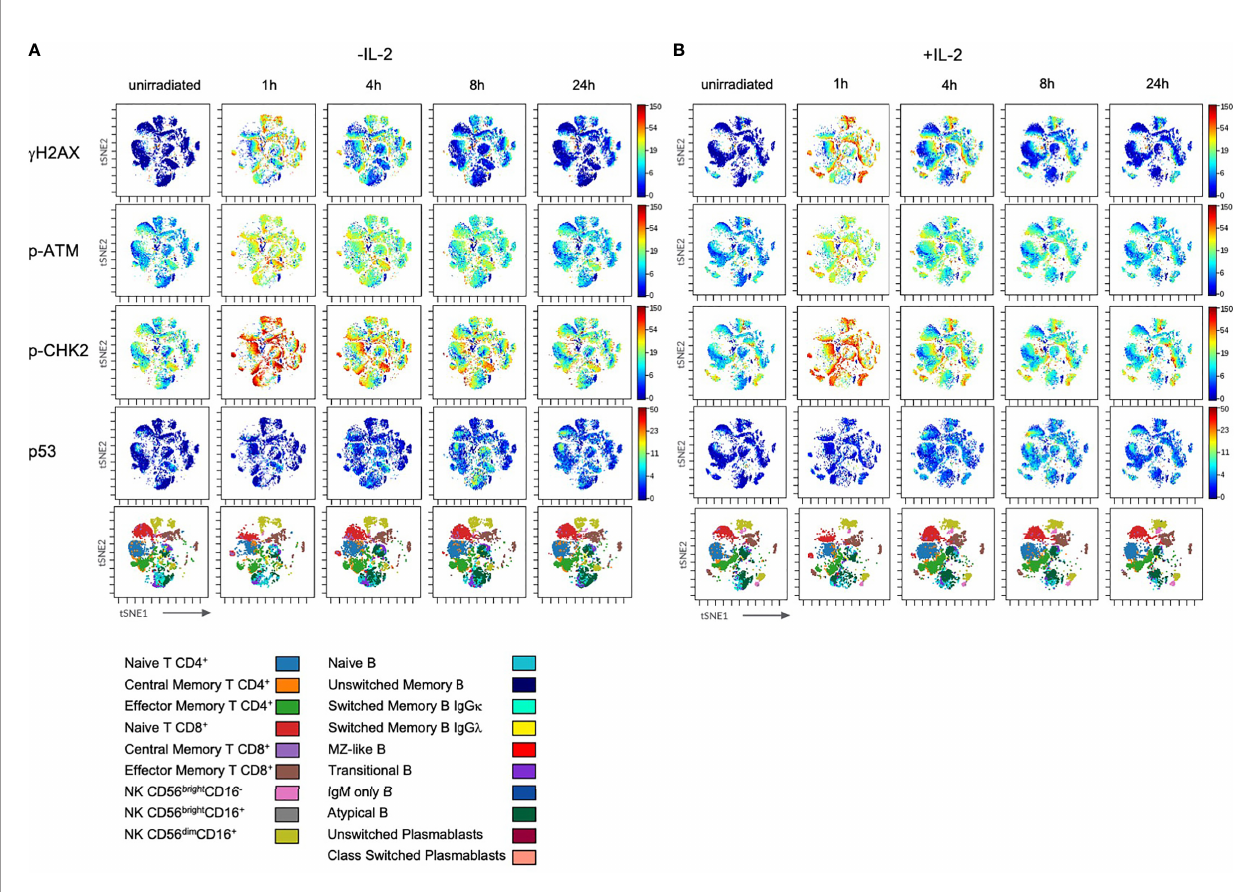
FIGURE 4 | Stimulation with IL-2 does not impact on DDR in lymphocyte subsets. PBMCs of healthy donors were cultured in RPMI media without (w/o) supplementation of IL-2 (A) and in presence of 100U/ml human IL-2 (B) for 48h. Subsequently, cells were irradiated with 2Gy and fi xed at indicated time points. Shown are tSNE Plots demonstrating expression level of DDR markers g H2AX, p-ATM, p-CHK2 and p53 on all populations analyzed at indicated time points. Scale bars on the right-hand side of each panel indicate intensities of DDR markers. The bottom panel of (A , B) , respectively, represent lymphocyte populations that are color coded by the legend underneath. This fi gure demonstrates one representative experiment of one donor out of